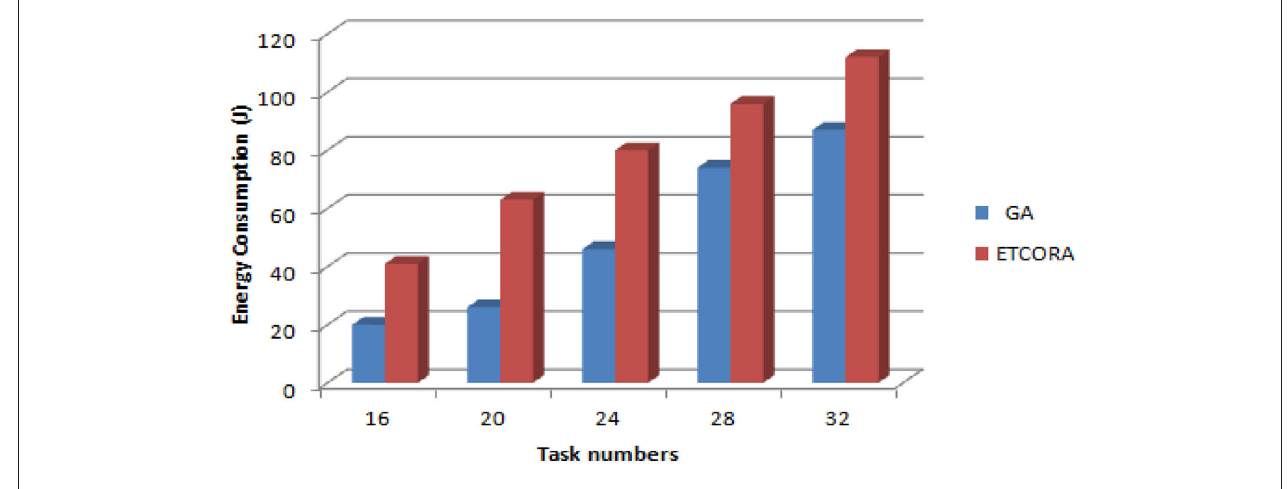
FIGURE 8 | Comparison between ETCORA and the proposed method.